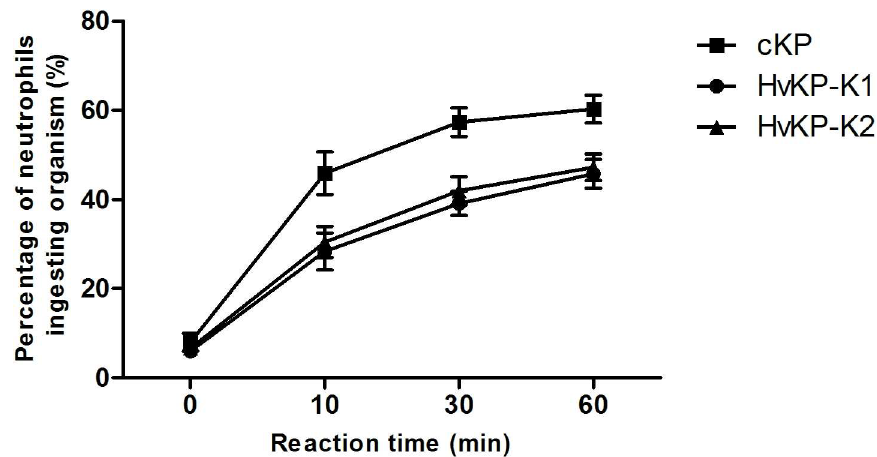
Fig 1. Phagocytosis of neutrophils against HvKP-K1, HvKP-K2 and cKP. The rate of phagocytosis againstcKP (15 isolates)was higherthan that againstHvKP-K1(16 isolates)or HvKP-K2 (14 isolates)at 10, 30, 60 min. The mean ± standard deviation(S.D.) of each group at each time point was calculated respectively. Statistics was performedusingone-wayanalysisof variancefor each time point. Differences between groups wereassessedby t test. At 10, 30, 60 min, HvKP-K1 vs. cKP or HvKP-K2 vs. cKP: p < 0.05.